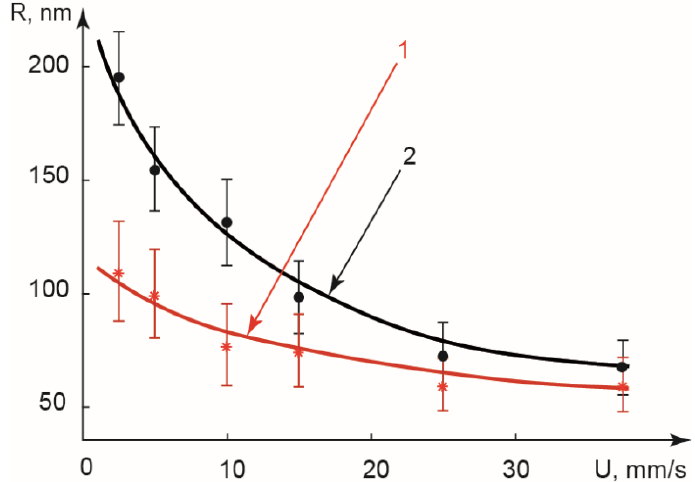
Figure 9. Hydrodynamic radii of PDADMAC-SDS complexes synthesized in serpentine microfluidic threads. Flowrate ratios φ = 1 (curve 1) and φ = 0.3 (curve 2).